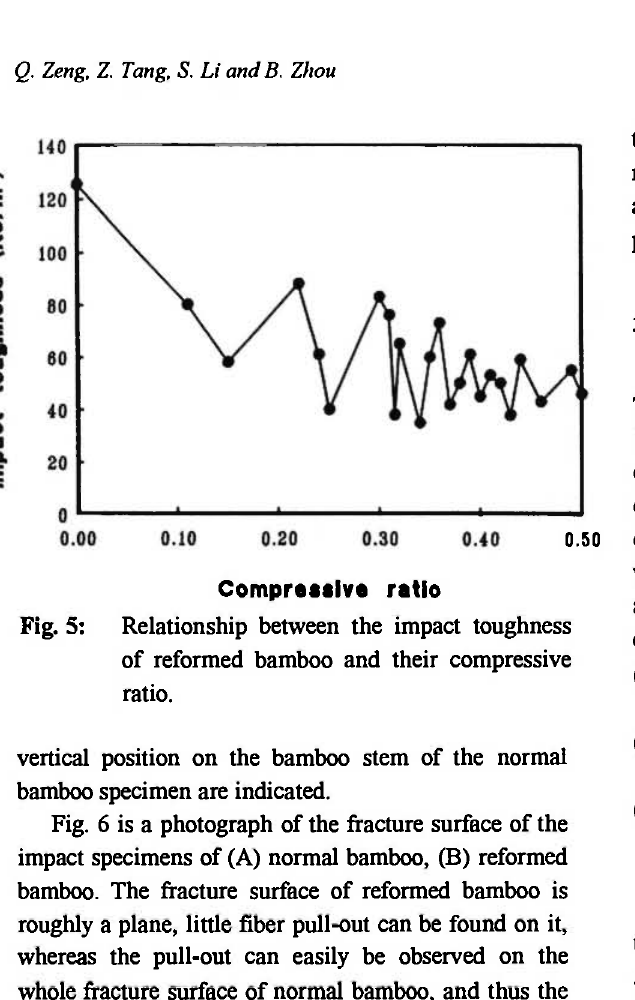
Fig. S: Relationship between the impact toughness of reformed bamboo and their compressive ratio.